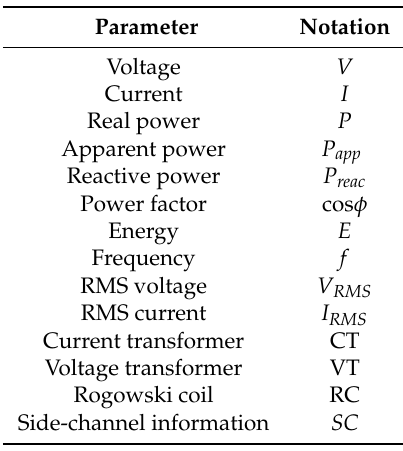
Table A1. Abbreviations used in the technical